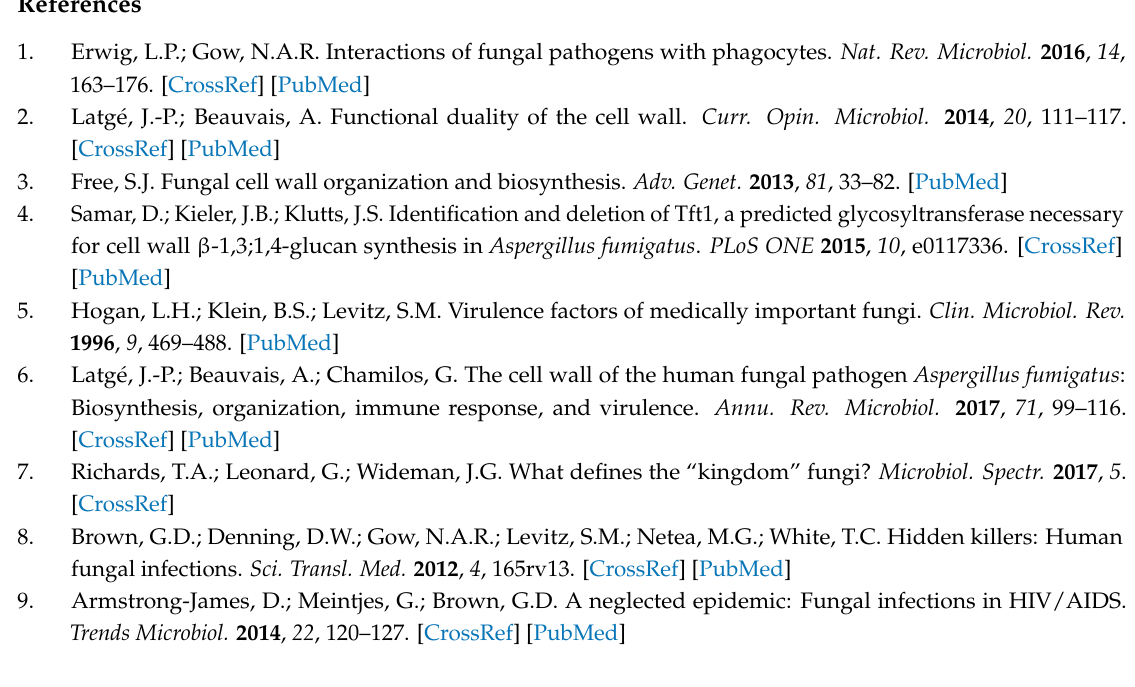
Table S1. (A) The list of genomes downloaded from NCBI genomes in July 2017 with corresponding literature references; (B) Cell wall related proteins with CaZy and Pfam identifiers; (C) Distribution and abundance of each CWP family in the 24 proteomes analyzed. Figure S1. Synthesis of GPI anchor in the ER; Figure S2. N -glycosylation schema; Figure S3. Further steps of N -glycosylation and mannan formation; Figure S4. O -mannosylation schema. Dataset S1. All sequence identifiers; Dataset S2. All phylogenetic trees in newick; Dataset S3. All phylogenetic trees in pdf